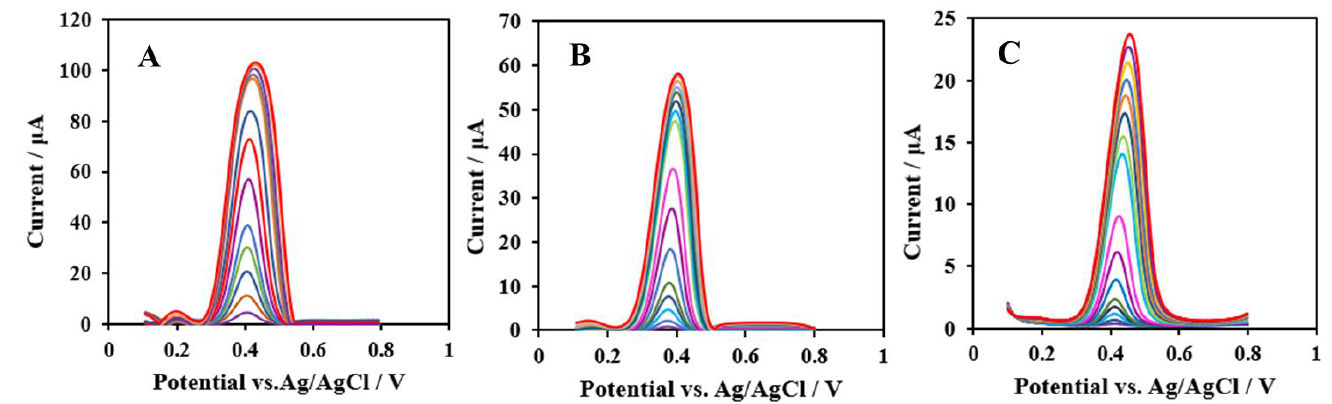
Figure 7. ( A ) SWV, ( B ) DPV, and ( C ) LSV of NF/IL/CMC-MWCNTs/GCE for the oxidation response